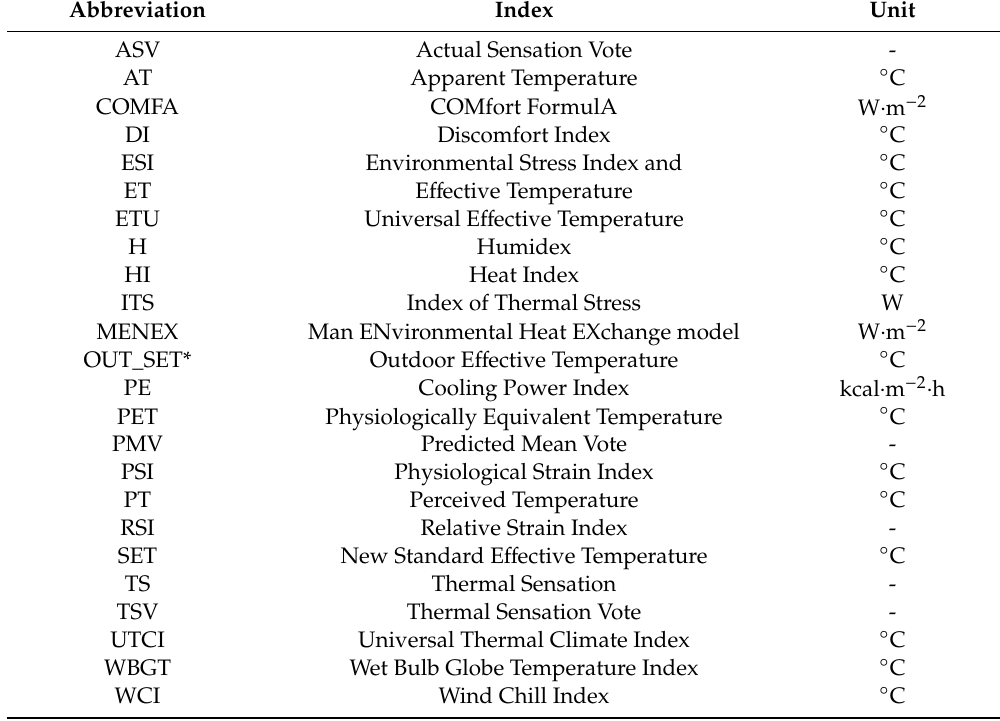
Table 2. Nomenclature of the main thermal comfort indexes